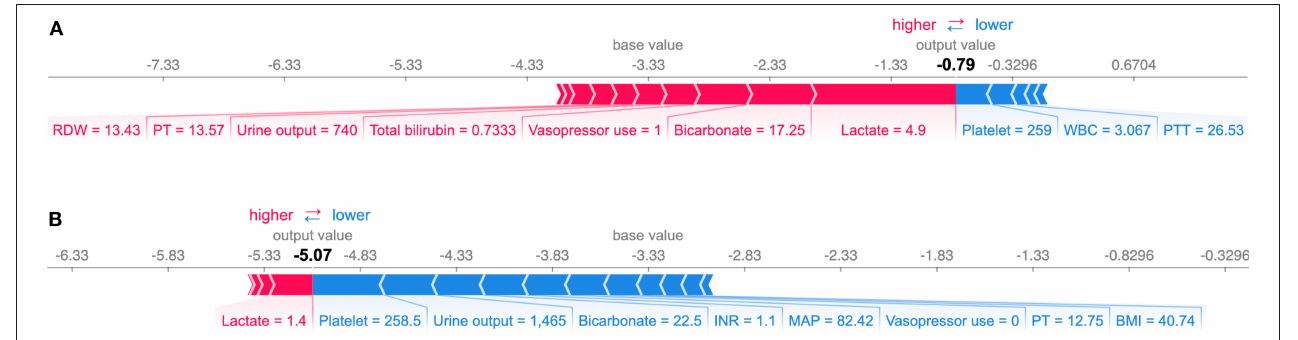
FIGURE 6 | Explanation of the prediction results for specific instances. The base value ( − 3.33) is the average value of the predictive model; the output values are the predicted SIC risks. The bars in red and blue represent risk factors and protective factors, respectively; longer bars mean greater feature importance. Here, these values are the model outputs before the SoftMax layer, and therefore, they are not equal to the final predicted probabilities. This figure shows the explanation for a high-risk instance (A) and a low-risk instance (B) . RDW, red cell distribution width; PT, prothrombin time; WBC, white blood cell count; PTT, Partial Thromboplastin Time; INR, international normalized ratio; MAP, mean arterial pressure; BMI, body mass